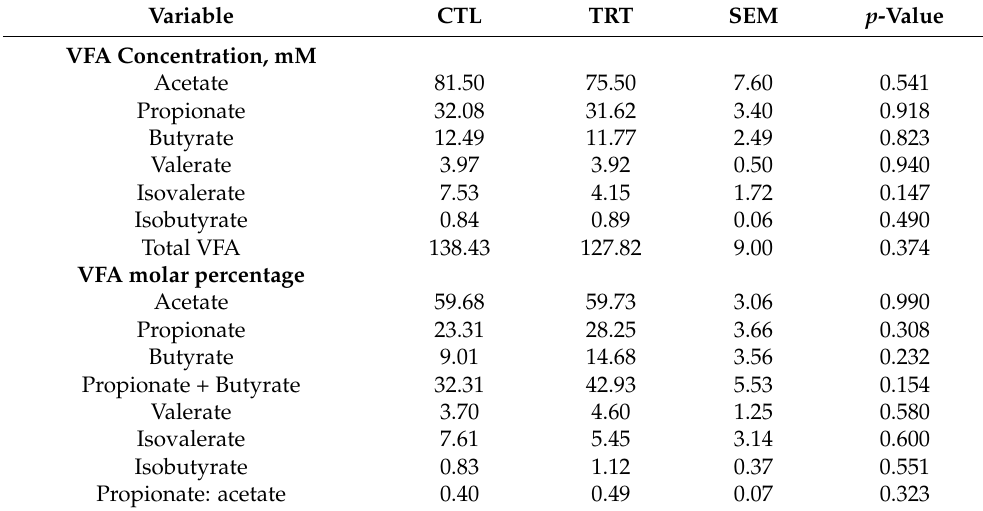
Table 3. The least-square means and associated standard error of the mean (SEM) for volatile fatty acid (VFA) concentrations and molar percentages of VFA in the rumen of control (CTL) and MCE-fed calves